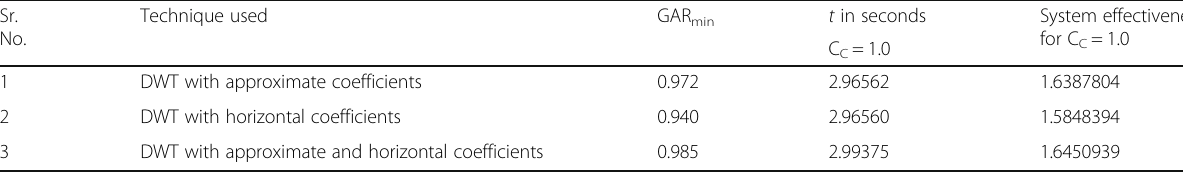
Table 7 Summary of results for C C = 1.0 Sr.